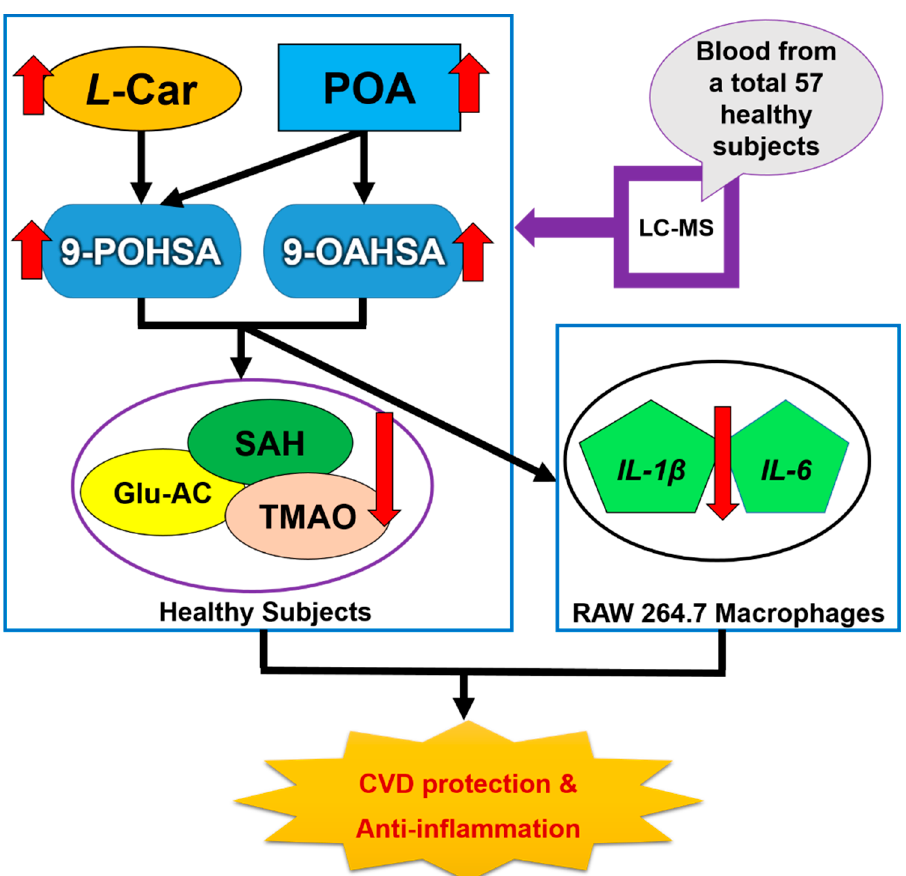
Figure 7. A schematic diagram depicting two major endogenous FAHFAs (9-POHSA and 9-OAHSA) in healthy human circulation, their CVD protection effects, and their anti-inflammatory effects on RAW 264.7 macrophages.